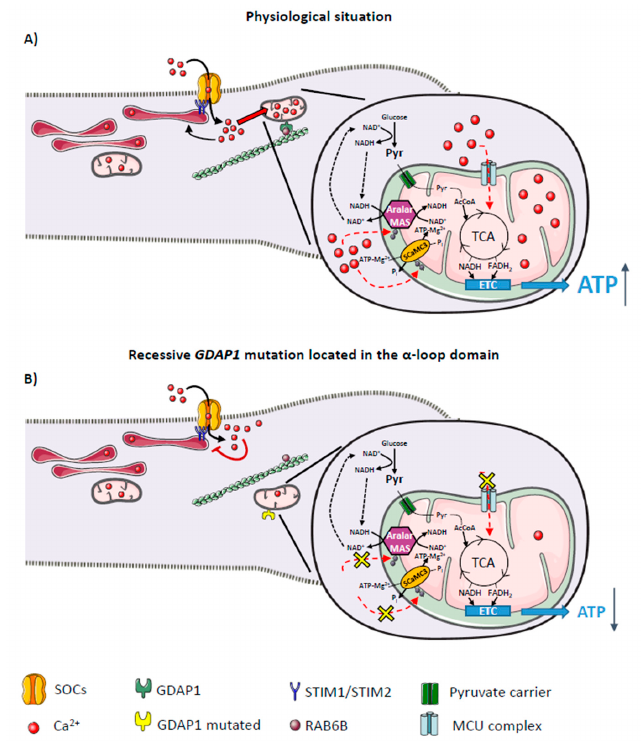
Figure 1. Effects of ganglioside-induced differentiation-associated protein 1 (GDAP1) on mitochondrial bioenergetic functions. ( A ) Interaction between GDAP1 and the trafficking proteins allows mitochondria to be located close to the plasma membrane after store-operated calcium entry (SOCE) activation, preventing its Ca 2+ -dependent inactivation. Ca 2+ uptake by mitochondria facilitates SOCE but also regulates ATP production by oxidative phosphorylation. Ca 2+ -dependent regulation of OXPHOS involves two main mechanisms (dotted red arrows); (i) Ca 2+ entry through the mitochondrial Ca 2+ uniporter complex (MCUc) and the activation of dehydrogenases of the tricarboxylic acid cycle (TCA), and (ii) activation of the neuronal Ca 2+ -dependent mitochondrial transporters of aspartate/glutamate (Aralar) or ATP-Mg/Pi (SCaMC-3). Aralar activation increases Malate/Aspartate shuttle (MAS) activity, transferring reducing equivalents from NADH to mitochondria and thereby increasing pyruvate (Pyr) supply to mitochondria to enhance mitochondrial respiration. SCaMC-3 activation increases mitochondrial adenine nucleotide pool (solid and dotted black arrows); ( B ) Mitochondrial movement might be affected by recessive mutations located in the α -loop of GDAP1 causing the loss of interaction with trafficking proteins RAB6B and caytaxin which might affect the proper mitochondrial localization at the subplasmalemmal microdomains and disturb SOCE activity (red T bar). Subsequently, this will also impair mitochondrial bioenergetic functions by either decreasing Ca 2+ uptake by MCUc and activation of matrix dehydrogenases, and/or by decreasing the activation of Ca 2+ -dependent mitochondrial